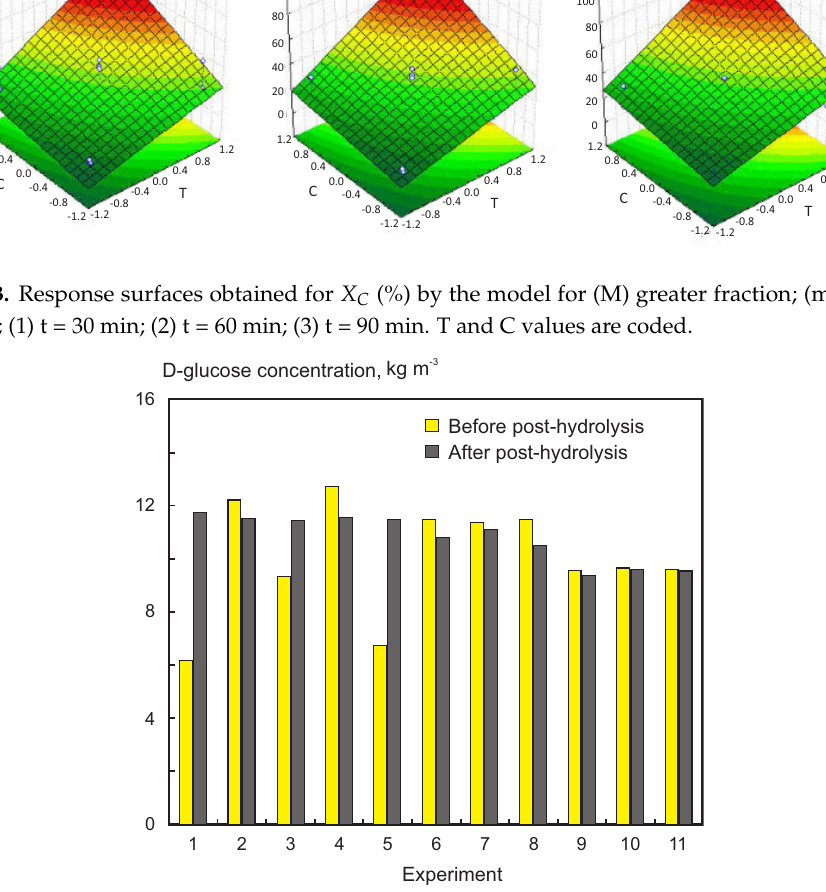
Figure 4. Comparison of D -glucose concentration before and after the determination of